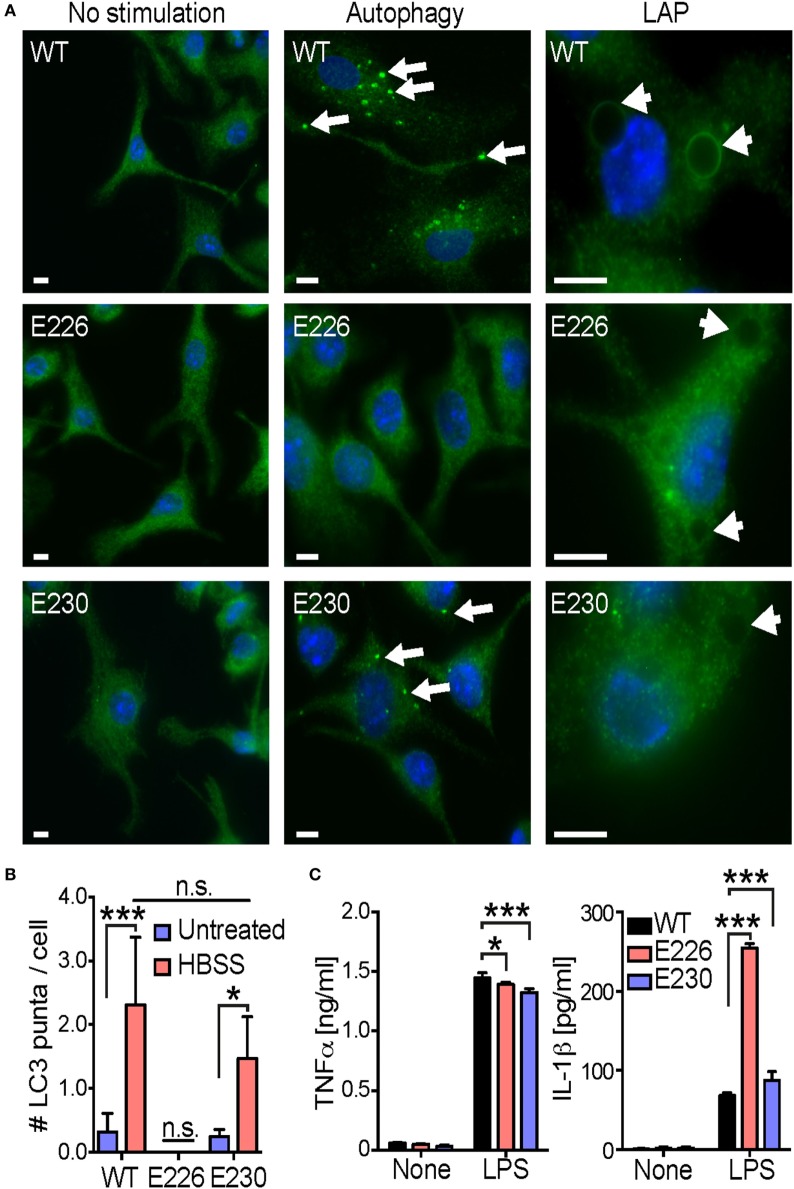
Analysis of autophagy and LAP in E226 and E230 BMDCs. (A) The autophagy and LAP phenotype in WT, E226, and E230 BMDCs were analyzed by staining LC3, when cells were starved (autophagy) and polystyrene beads were taken up (LAP), respectively. White bar indicates 5 µm. Arrows and arrow heads show LC3 puncta and internalized beads, respectively. (B) The number of starvation-induced LC3 puncta in the cell was counted around 100 cells per each genotype. (C) WT, E226, and E230 BMDCs were stimulated with 100 ng/ml of lipopolysaccharide. After 16 h incubation, the supernatant was harvested, and the amount of TNFα and IL-1β was measured by an ELISA. Data shown are the mean of triplicates ± SD from one representative experiment and reproducible in three independent experiments. Statistical analyses were performed by one-way ANOVA followed by Tukey’s test.